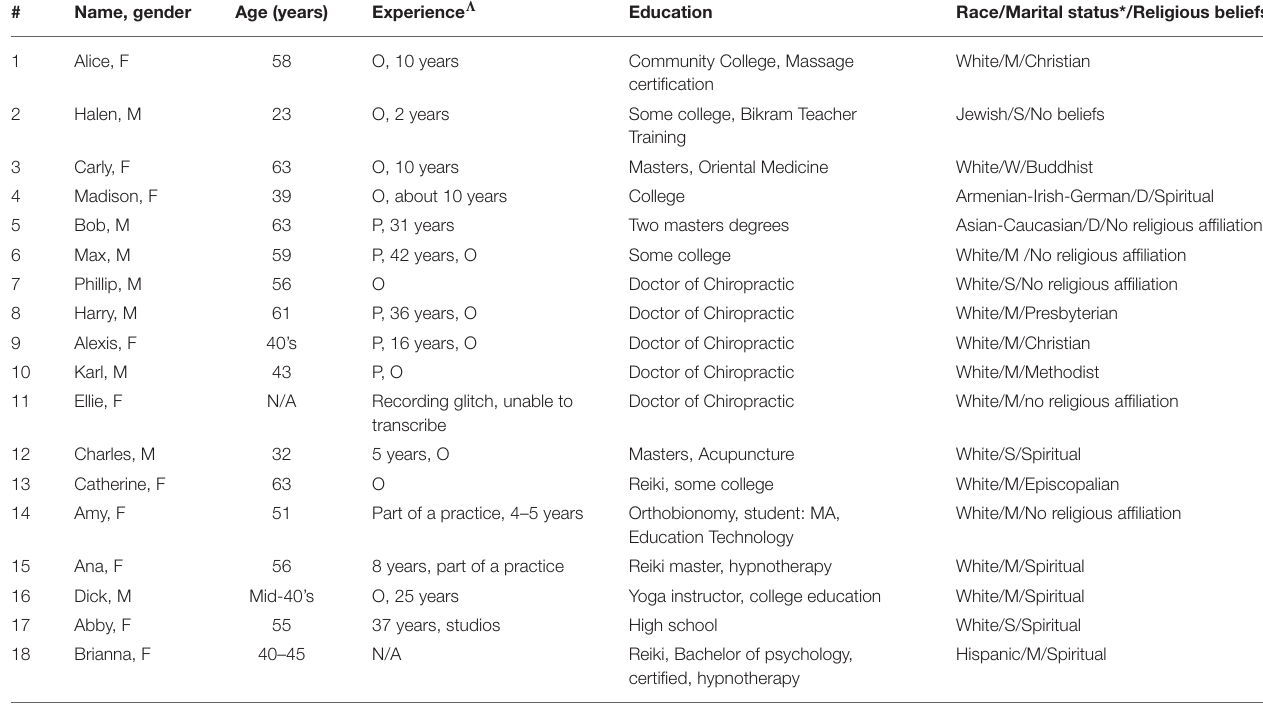
TABLE 1 | Participant